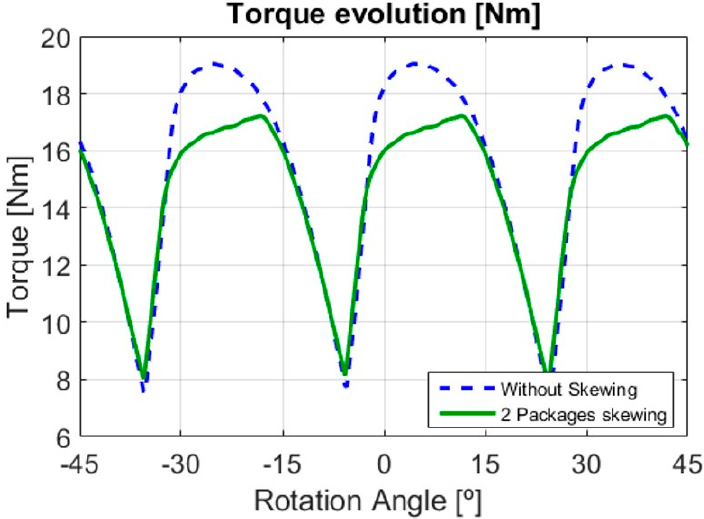
Figure 3. 2D torque curve without skewing (dashed blue line); 2D torque curve with 2 skewing packages (green line). In the paper, continuous lines represent analytical results, while dashed lines represent FEM results.